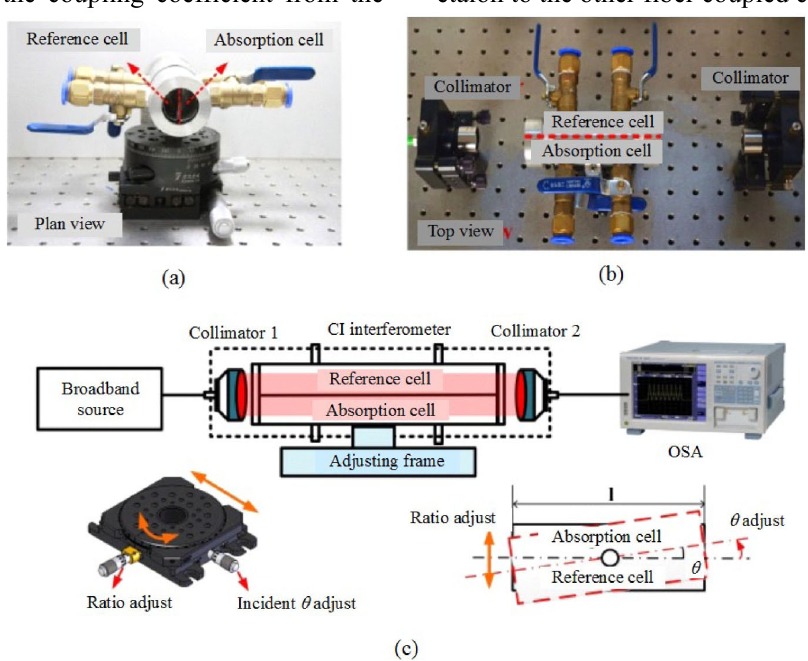
Fig. 1 Gas conjugated interferometer: (a) plan view of CI, (b) top view of CI, and (c) working principle of CI. If r = 50%, (3) can be simplified as follows: